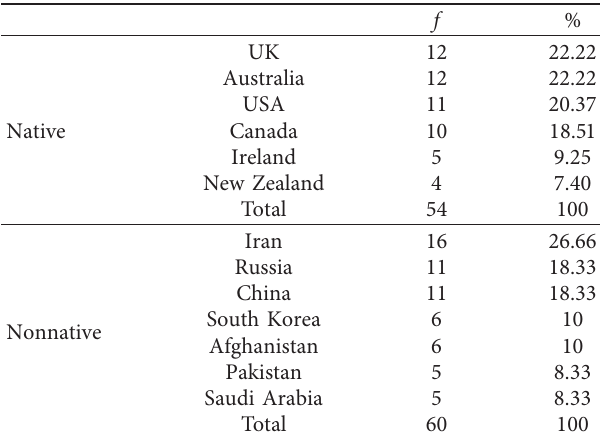
Table 2: Participants’